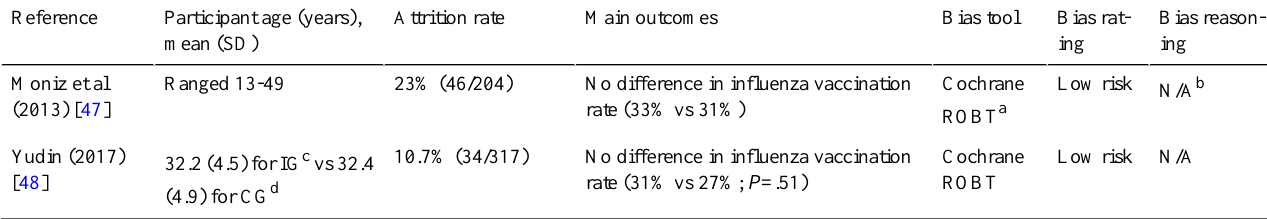
Table 6. Outcomes and bias of trials with a focus on influenza